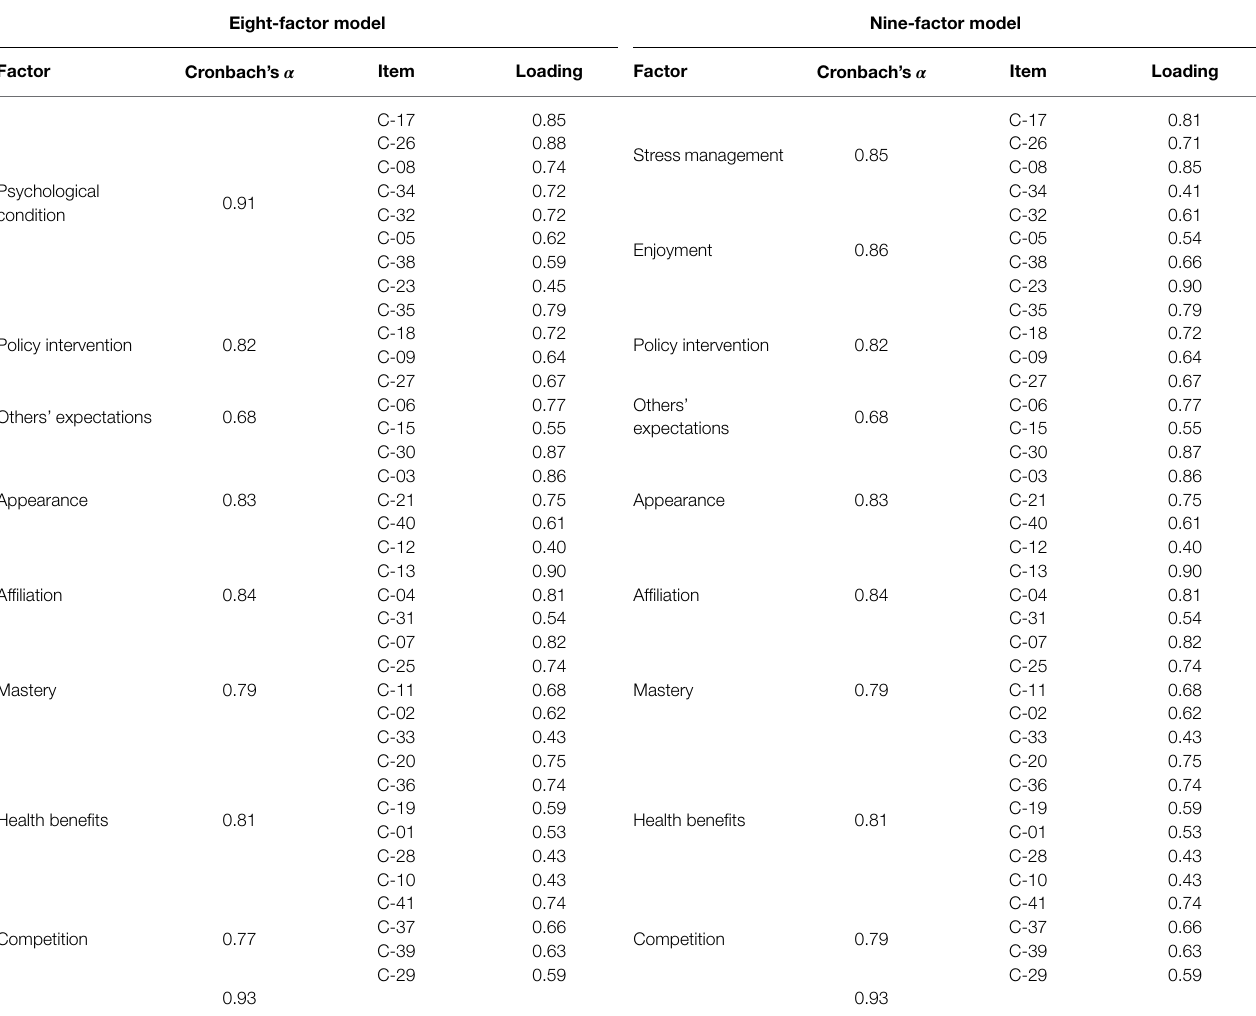
TABLE 4 | Exploratory factor analysis (EFA) for the factors of the CUSPAM.